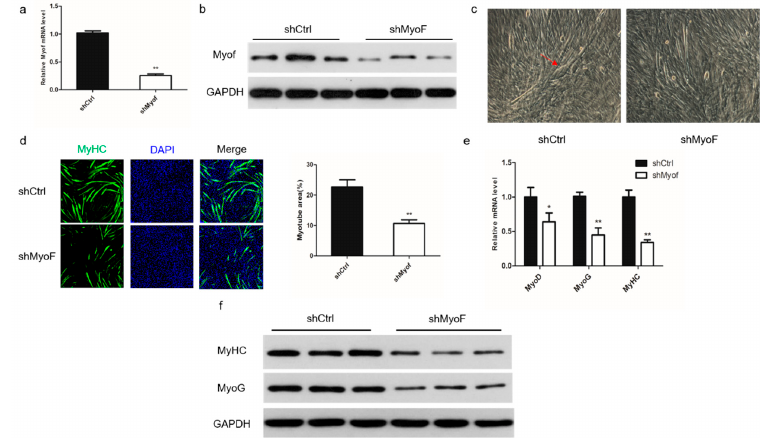
Figure 2. MyoF silencing reduces myoblast differentiation. C2C12 myoblasts were transfected with shMyoF or scramble plasmid (shCtrl) and expanded in growth medium or induced to differentiate into myotubes in differentiation medium. ( a,b ) qRT-PCR and Western blot analyses of MyoF mRNA and protein expression in MyoF-silenced and shCtrl cells, respectively; GAPDH was used as loading control. ( c ) Representative images of myotubes generated by cells transfected with shCtrl and shMyoF. ( d ) C2C12 cells transfected with MyoF-shRNA and shCtrl plasmid were cultured in differentiation medium for 72 h, then stained with MyHC antibody and DAPI (nuclei). The bar graph on the right shows the myotube area (%) after transfection with shRNA or shMyoF. ( e,f ) qRT-PCR and Western blot analyses of MyoD, MyoG, and MyHC mRNA and protein levels in MyoF-silenced and shCtrl cells, respectively; GAPDH was used as loading control. Data represent means ± SEM ( n = 3 independent cell cultures). * p < 0.05; ** p < 0.01.